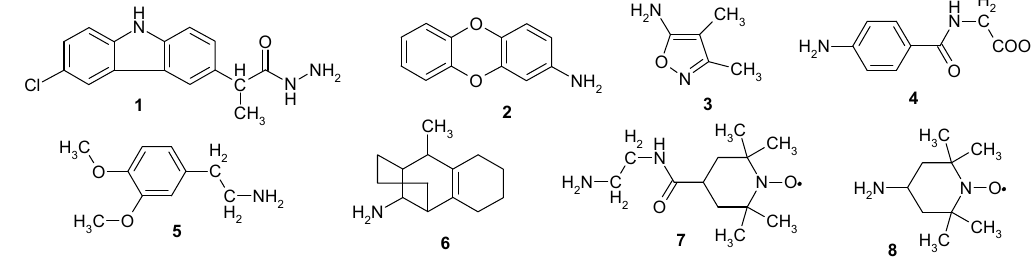
Figure 1. Chemical structures of the amines used in this study.